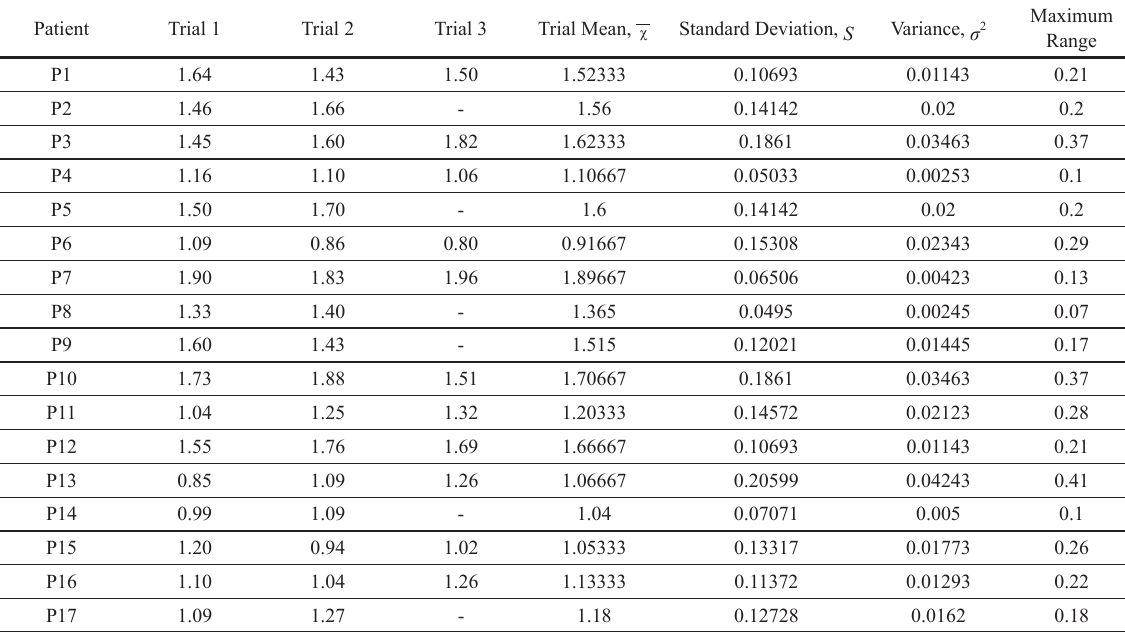
Summary of 2D data collection for B-mode ultrasonic NT marker